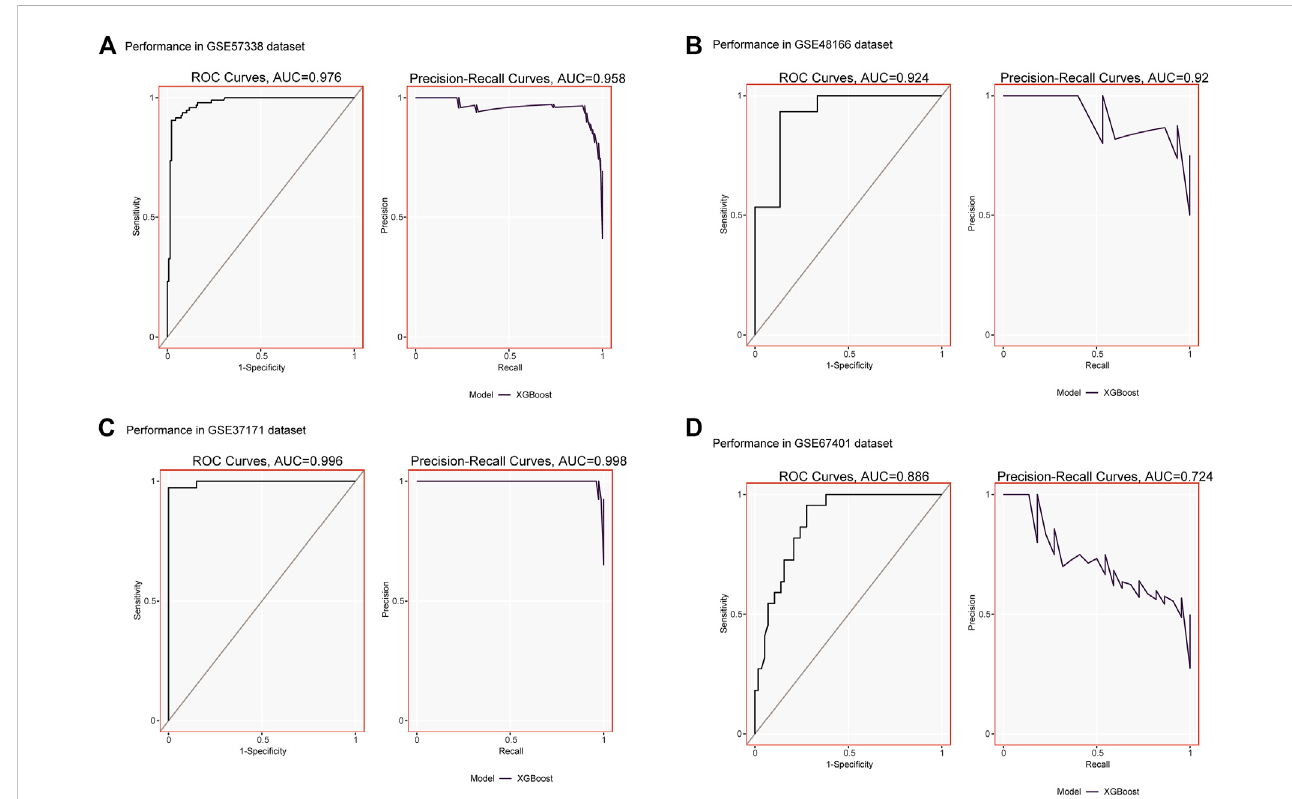
FIGURE 7 (A) XGBoost modeling in the HF training set (GSE57338). (B) Validation through the HF validation set (GSE48166). (C) XGBoost modeling in the ESRD training set (GSE37171). (D) Validation through the ESRD validation set